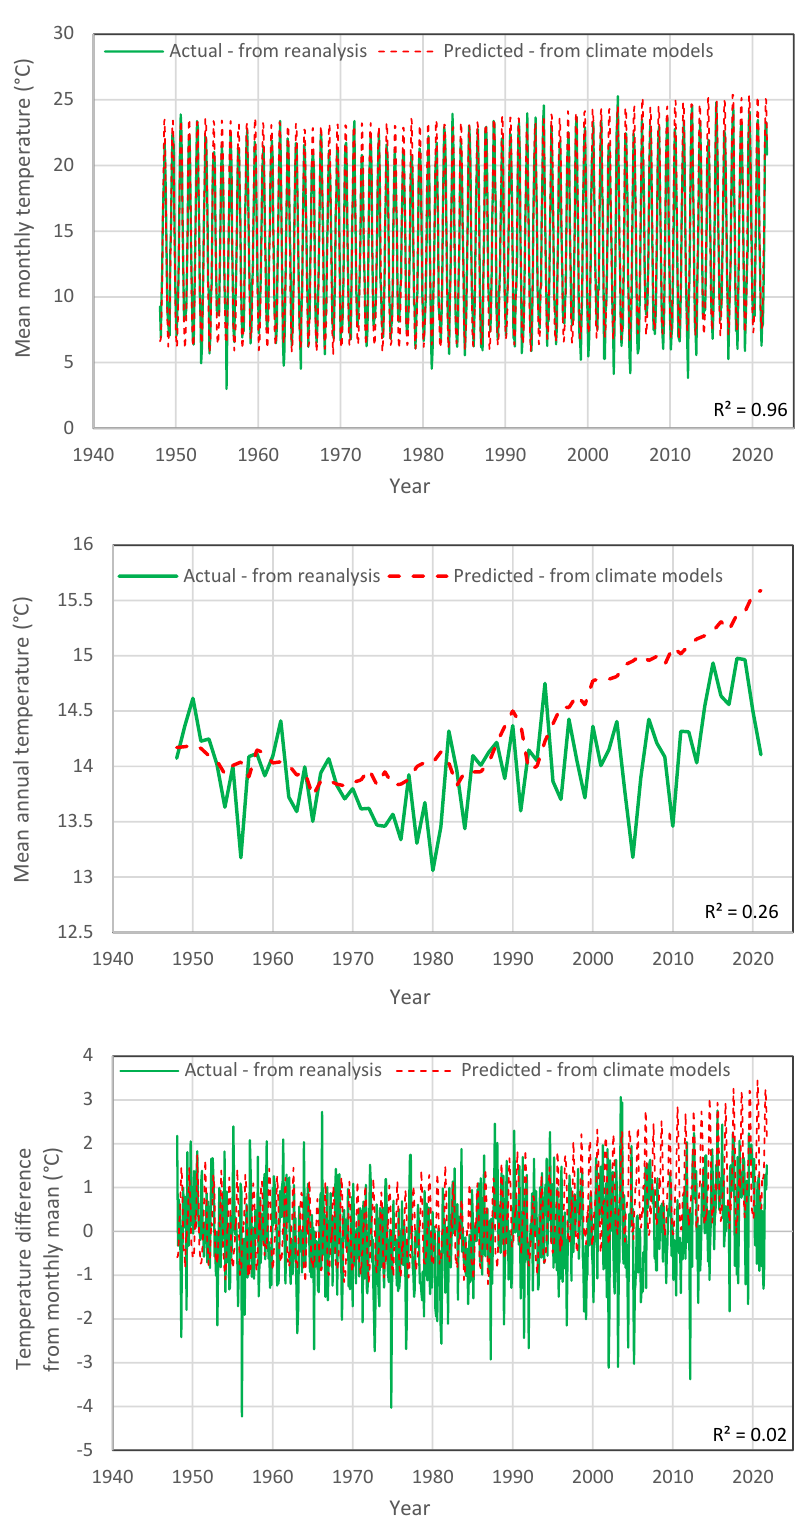
Figure 2. Comparison of the actual and D-model temperature data: ( upper ) original monthly data; ( middle ) after the aggregation to annual scale; ( lower ) after the subtraction of monthly means to reduce the effect of periodicity.